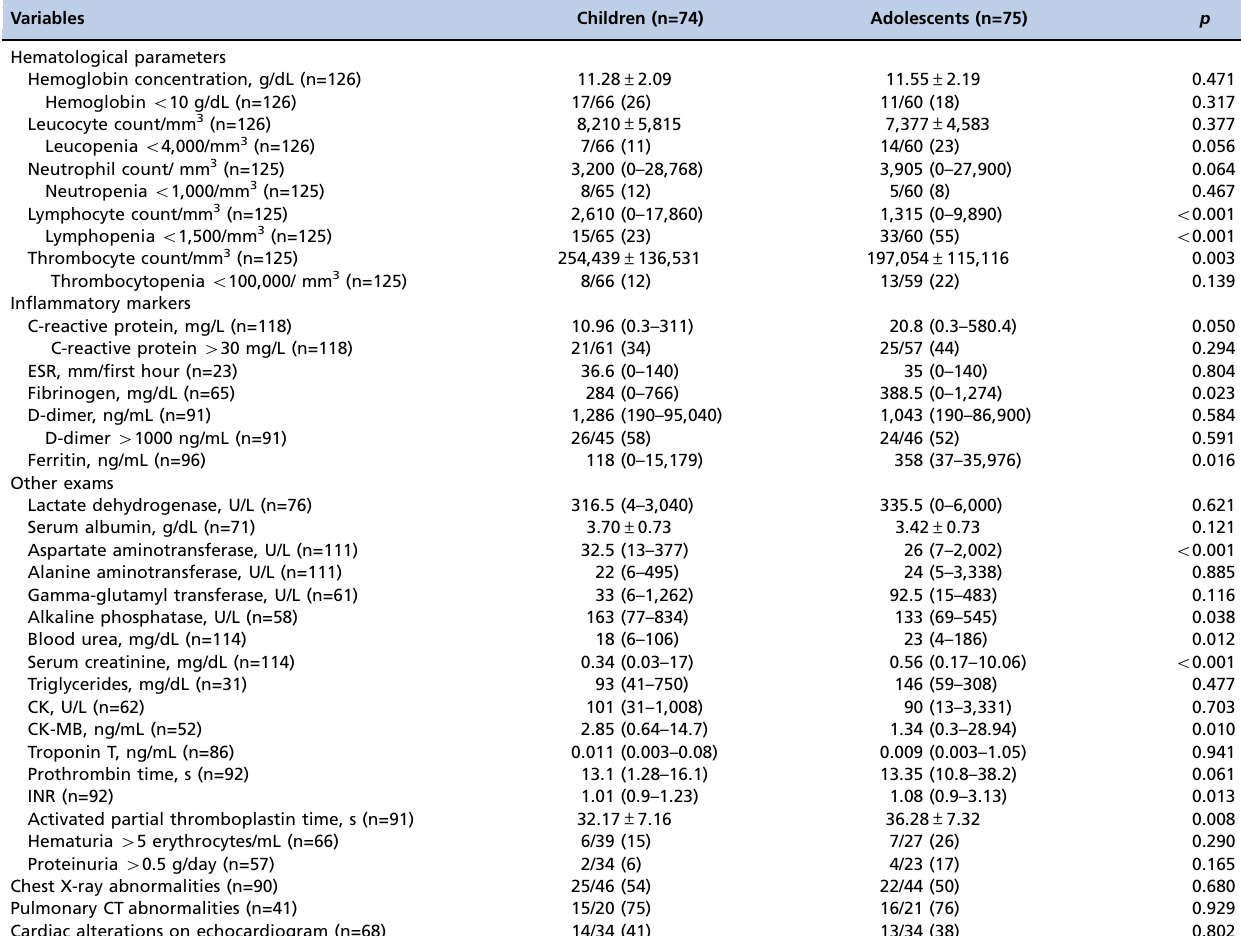
Table 2 - Laboratory tests and imaging abnormalities in children (aged o 10 years) vs. those in adolescents ( X 10 years) with laboratory- confirmed coronavirus disease 2019 (COVID-19).